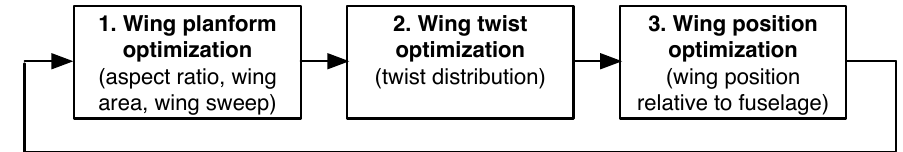
Figure 3. Schematic diagram of the aircraft redesign